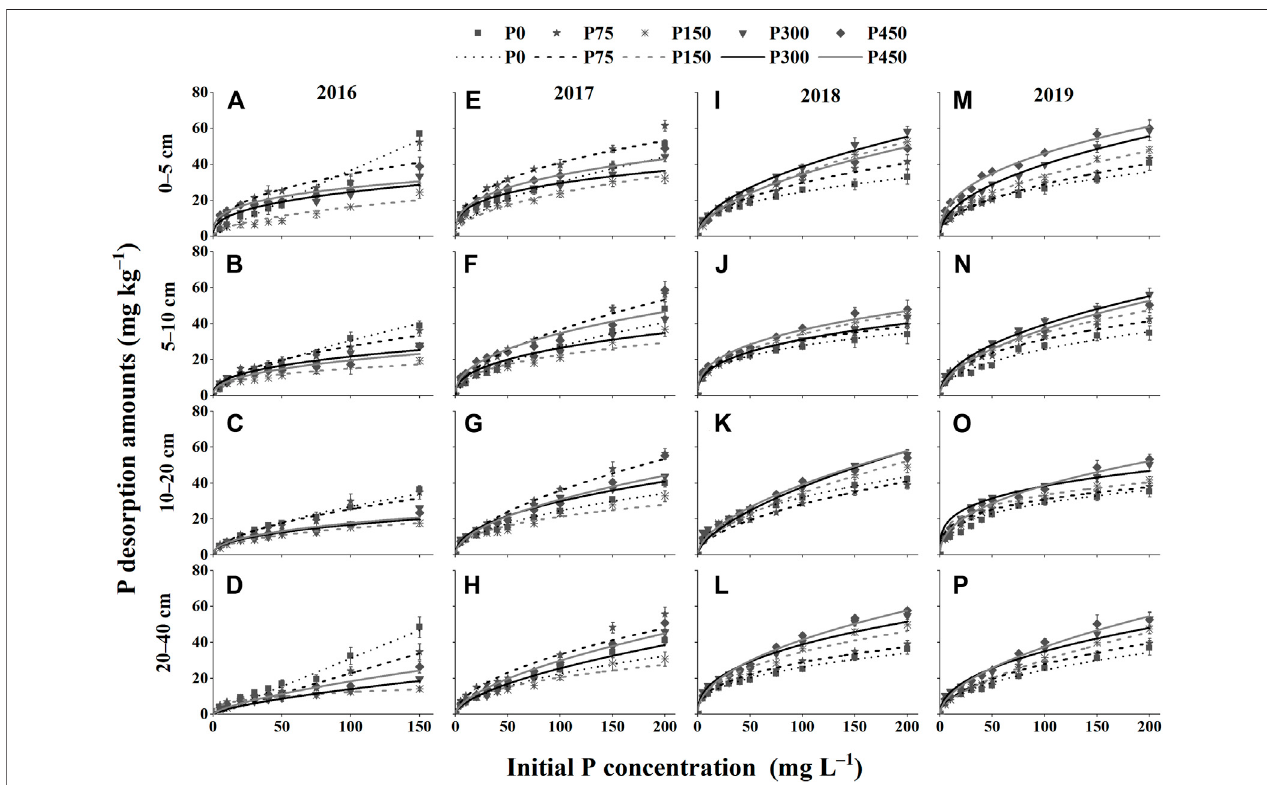
FIGURE 4 | Phosphate isothermal desorption curves of different treatments in 2016 – 2019. (A – D) 0 – 5, 5 – 10, 10 – 20, and 20 – 40 cm in 2016; (E – H) 0 – 5, 5 – 10, 10 – 20, and 20 – 40 cm in 2017; (I – L) 0 – 5, 5 – 10, 10 – 20, and 20 – 40 cm in 2018; and (M – P) 0 – 5, 5 – 10, 10 – 20, and 20 – 40 cm in